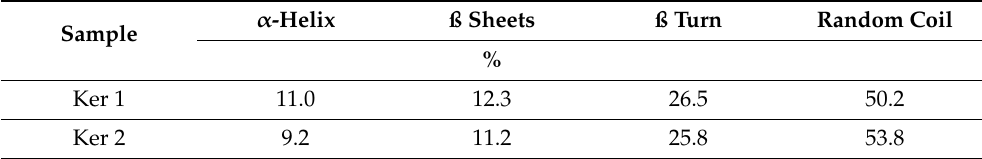
Table 3. Secondary structure percent composition obtained from deconvolution of Amide III band of keratin